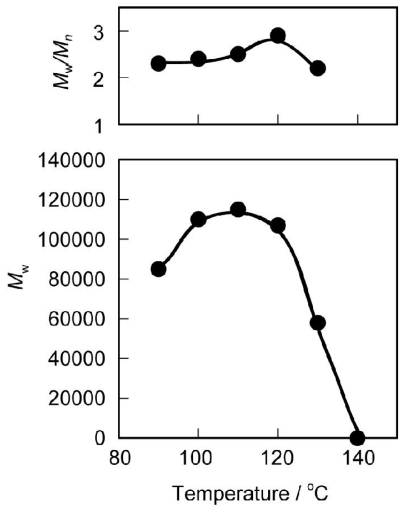
Effect of temperature on Mw and Mw/Mn of PEEU(6). Reaction conditions: 2 (11.4 mg, 0.02 mmol), hexaethylene glycol (5.6 mg, 0.02 mmol), 1,2-dimethoxybenzene (0.057 mL), CALB (4.6 mg), 48 h.